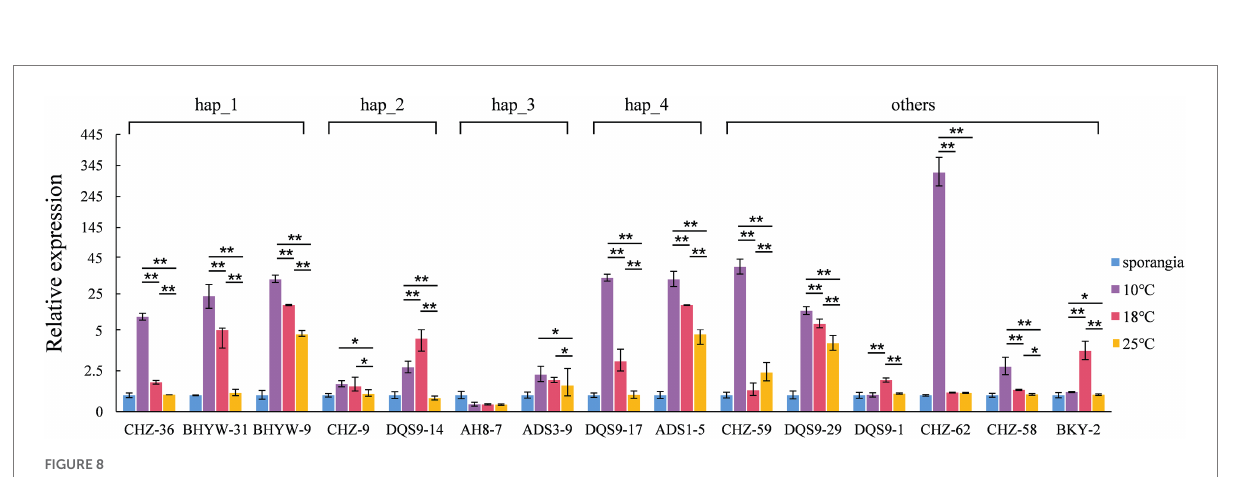
FIGURE 8 The expression of Pi02860 haplotypes under 10, 18 and 25 °